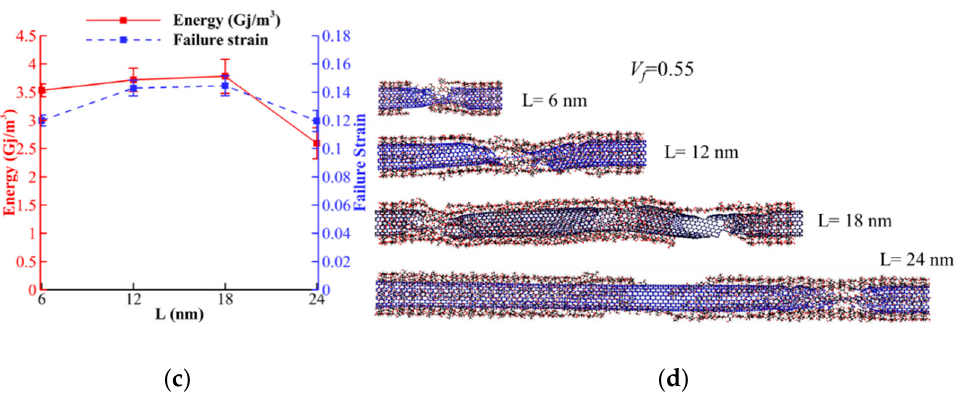
Figure A1. Effect of length on the tensile properties of CNT-wrapped cellulose with V f = 0.55 . ( a ) Stress-strain curves. ( b ) Variation of strength and Young’s modulus for length. ( c ) Variation of toughness and failure strain for different lengths. ( d ) Fractured model for different lengths shows a similar failure mechanism.